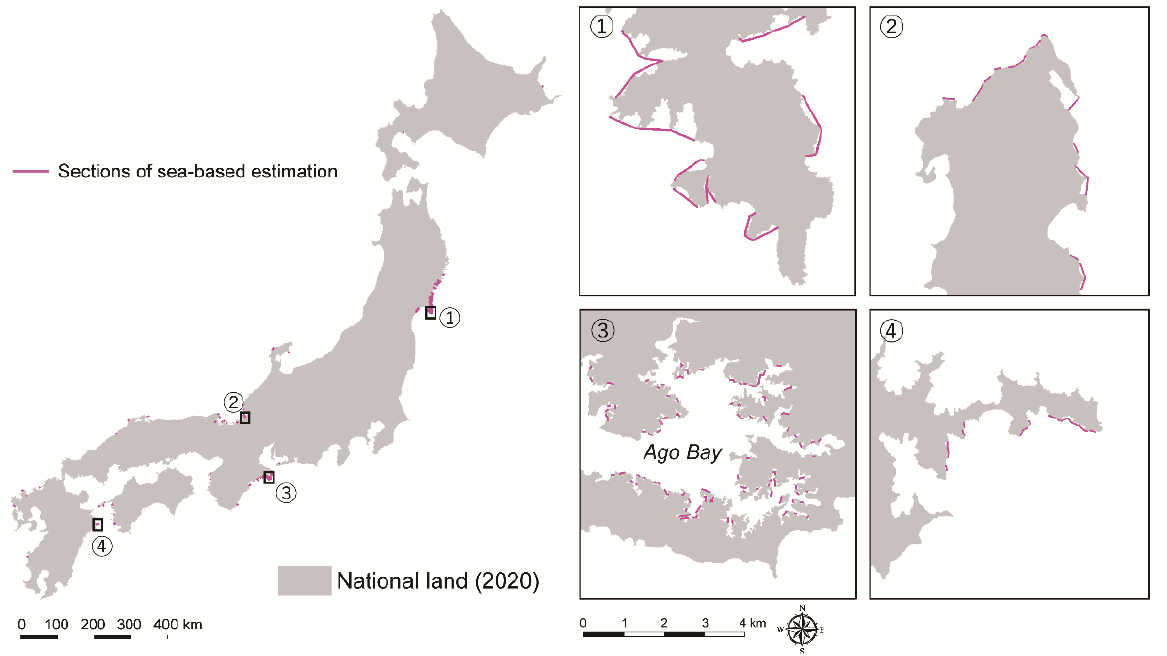
Figure 9. Distribution of the map sections drawn by sea-based measurement. The right maps show the enlarged views of each area. Source: Digital Inoh’s Map.